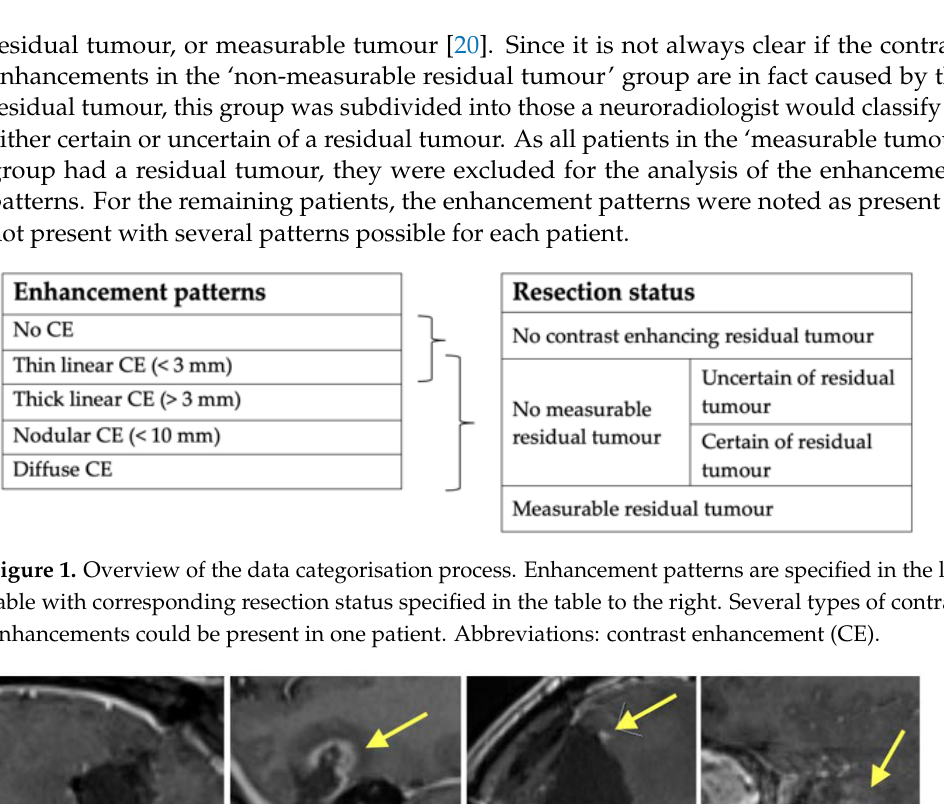
Figure 2. Examples of contrast enhancement. Enhancement patterns are marked with yellow ar- rows.